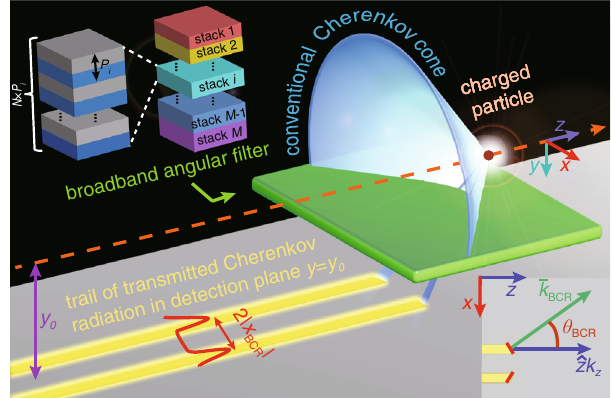
Fig. 1 Schematic of the proposed Brewster-Cherenkov detector based on a broadband angular fi lter. In our design, the charged particle moves along a trajectory far away from the surface of the broadband angular fi lter. The broadband angular fi lter [see the structural schematic in the top-left inset] is designed by exploiting the Brewster effect in many stacks of 1D photonic crystals with various periodicities but two same constituent materials. After the angular fi ltering, the transmitted Cherenkov radiation in the detection plane has cos θ BCR ¼ k z = j (cid:1) k BCR j [bottom-right inset], where k z = ω / v and (cid:1) k is the tangential wavevector of light parallel to the detection plane. The BCR measurement of the peak-intensity position | x BCR /y 0 | of Cherenkov radiation in the detection plane provides the information of the pseudo Brewster-Cherenkov angle θ BCR and the particle velocity, and it thus can be exploited for particle identi fi